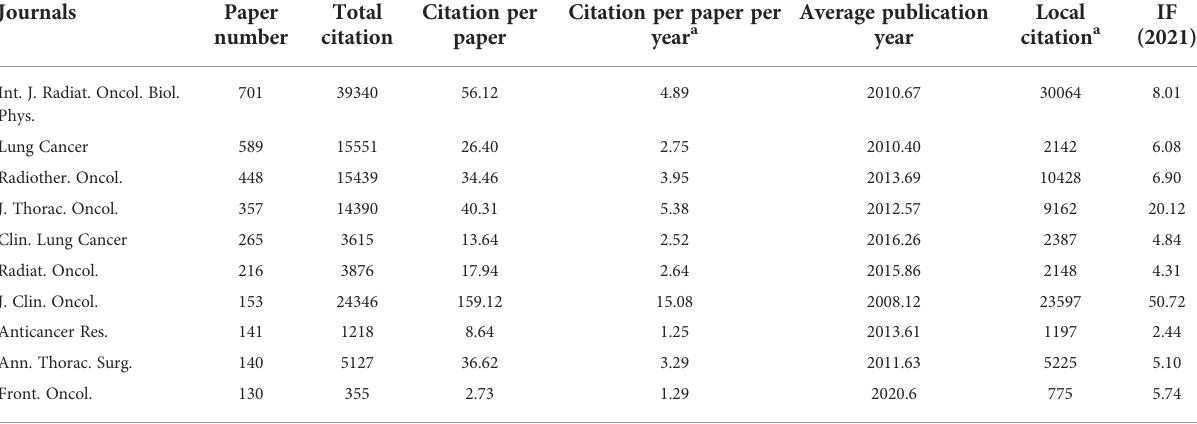
TABLE 2 The top 10 productive journals in lung cancer radiotherapy from 2000 to 2022. Journals Paper